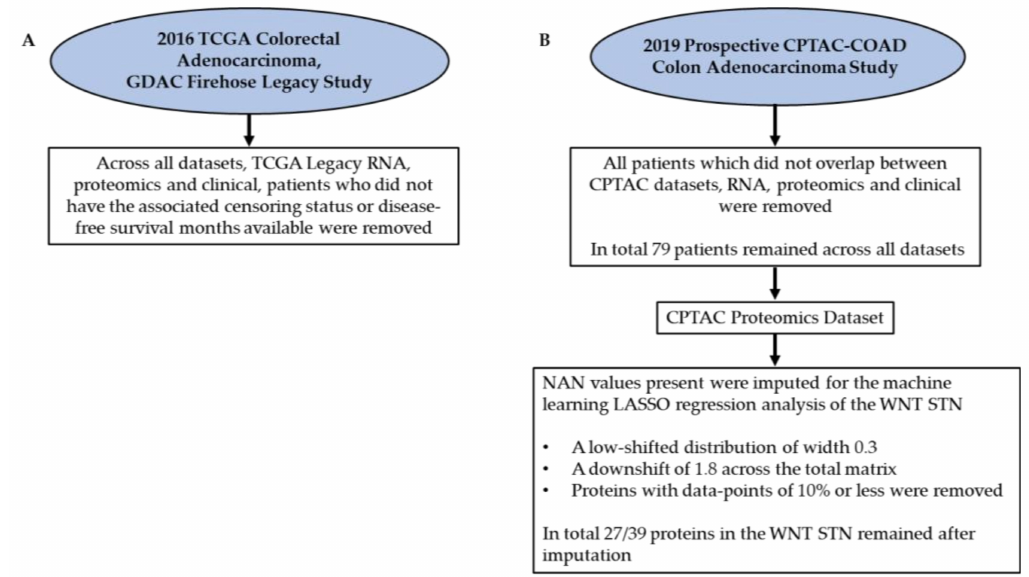
Figure 9. Pre-processing flow chart detailing all pre-processing steps completed prior to each analysis. Pre-processing flowchart for, ( A ) the 2016 TCGA Colorectal Adenocarcinoma, GDAC Firehose Legacy Study and ( B ) the 2019 Prospective CPTAC-COAD Colon Adenocarcinoma